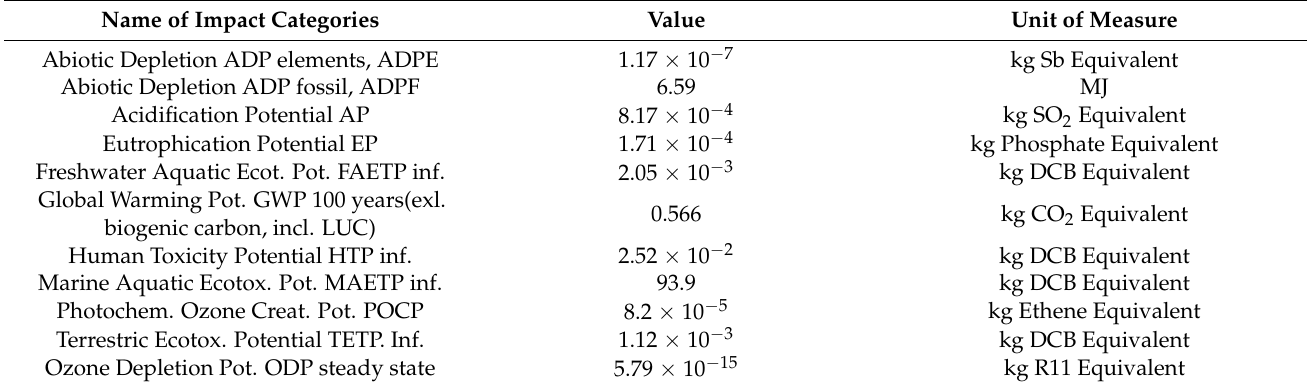
Table 7. The absolute values of environmental impacts in